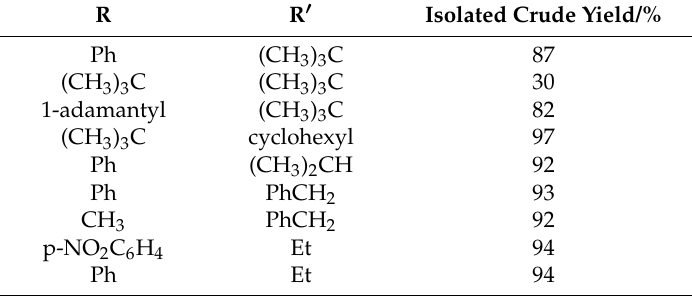
Table 7. Ester 41 (R 1 COOR 2 ) formation from the reaction of N -alkoxy- N -chloroamides 25 (R 1 CONClOR 2 ) with sodium azide in aqueous acetonitrile.